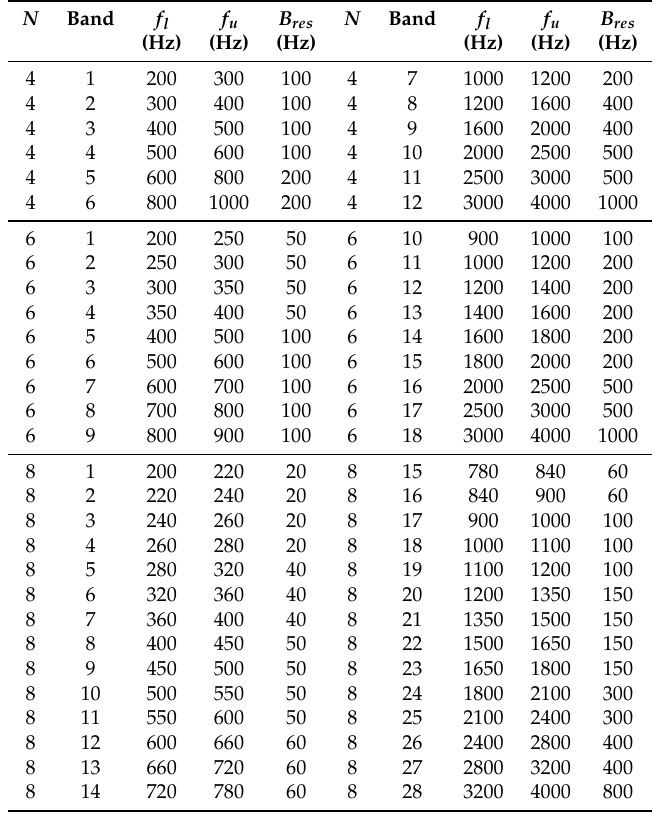
Figure 2. The radiation results comparison with four loudspeakers at ( a ) 200 Hz and ( b ) 300 Hz, six loudspeakers at ( c ) 200 Hz and ( d ) 250 Hz, and eight loudspeakers at ( e ) 200 Hz and ( f ) 220 Hz. Table 1. The band and its corresponding lower feaquency f l , upper frequency f u and bandwidth B res for the line loudspeaker array with N = 4,6,8